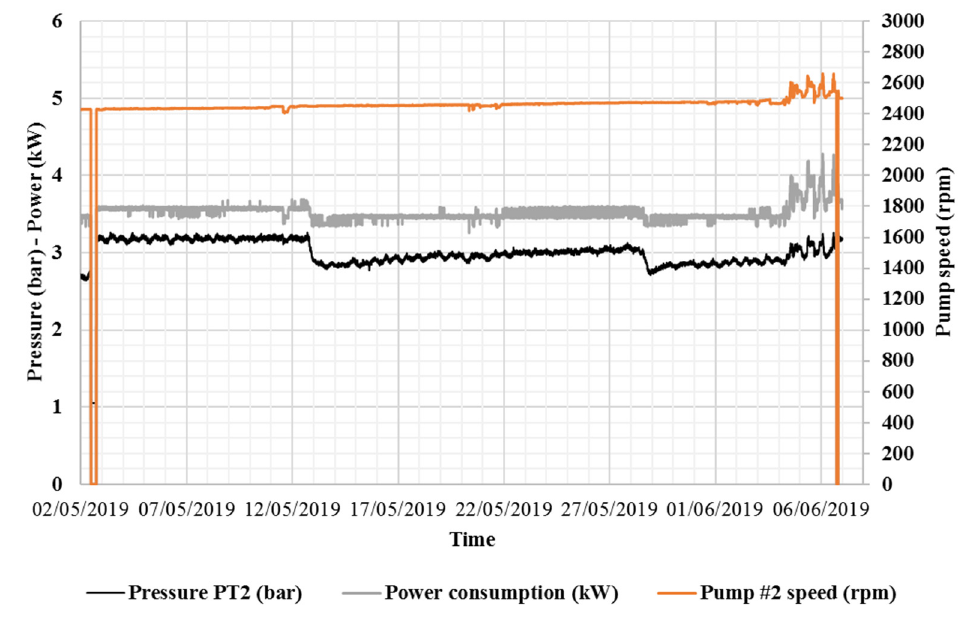
Figure 10. Monitored pressure, power consumption and motor speed on ejector line n°2 in the period from 2nd of May 2019 to 6th of May 2019 (between two external cleaning operations).